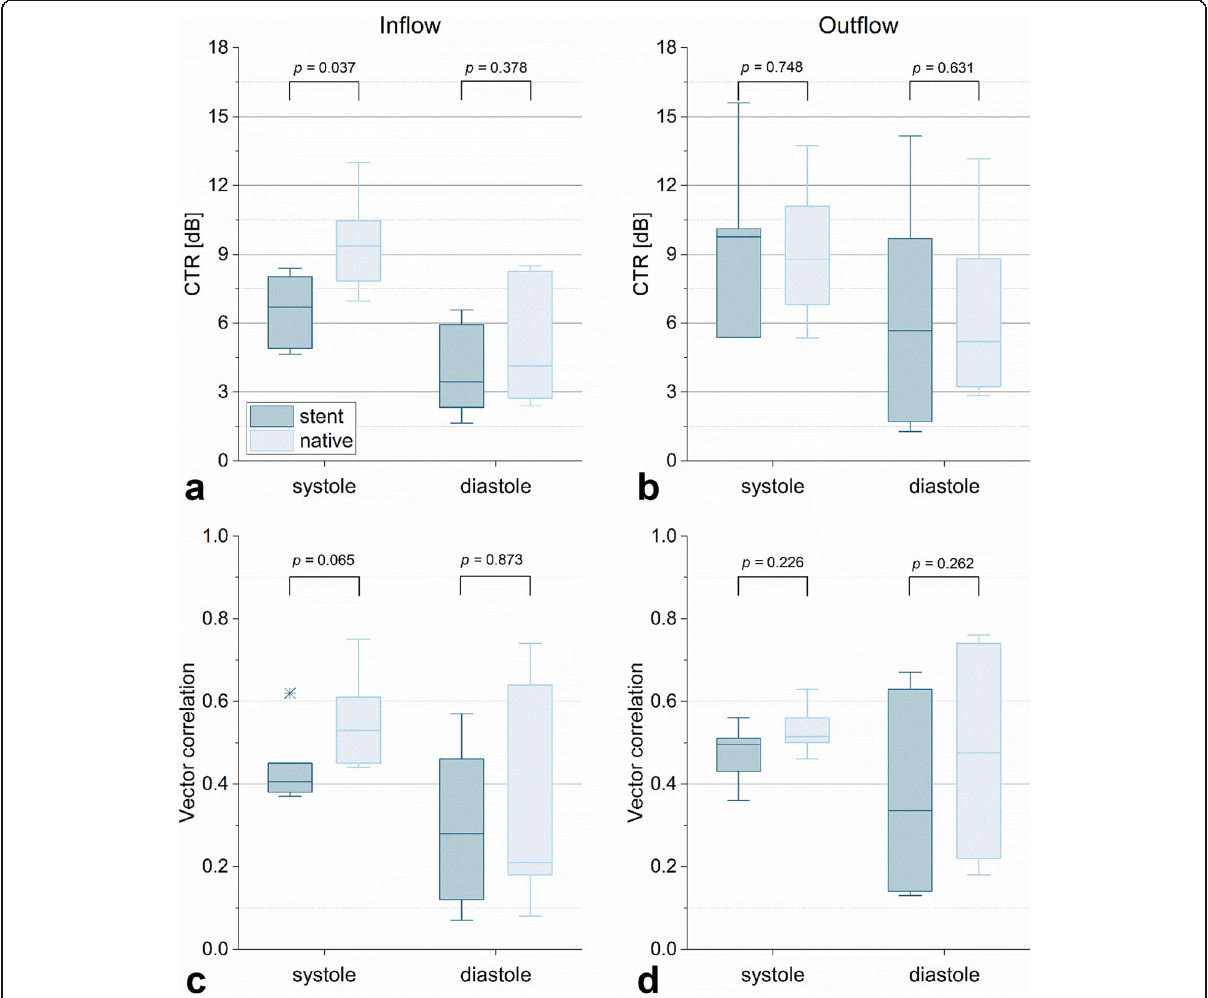
Fig. 6 Comparison of contrast-to-tissue ratio (CTR) ( a , b ) and vector correlation ( c , d ) between a stented and native vessel segment. Stented segment is presented in dark blue, whereas native segment is given in light blue. Edges of the boxes indicate the 25th (Q1) and 75th (Q3) percentiles, whereas whiskers give the minimum and maximum values. Outliers are presented as crosses. * p < 0.05, ns Not